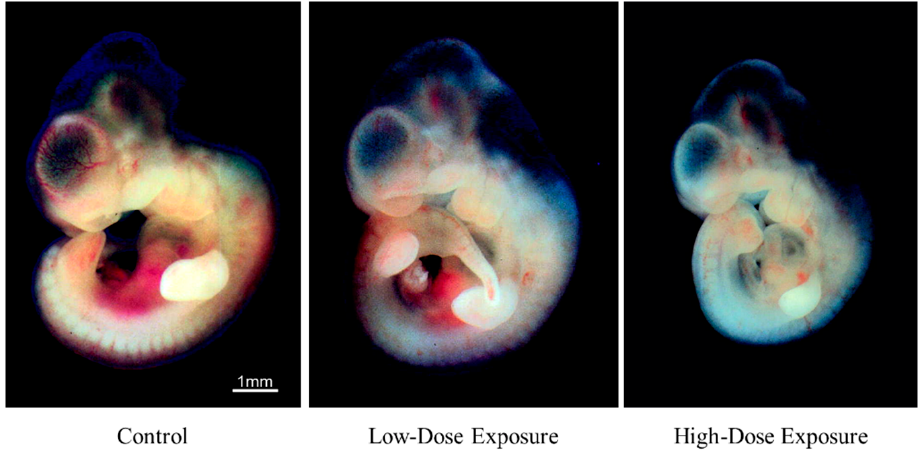
Figure 4. Morphological changes in rat embryos cultured for 48 h with low- and high-dose organohalogen contaminants from whale bacon. Whole cultured rat embryos with placenta and yolk sac. Scale bar = 1 mm.